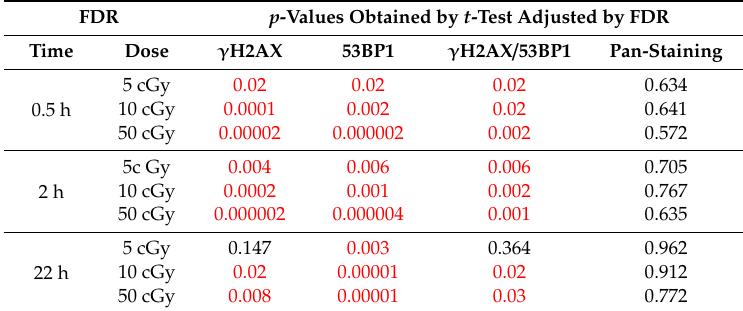
Table 2. Comparison of DNA repair foci and pan-staining in irradiated and control cells. Effect of irradiation was statistically compared with the sham-irradiated sample at the same time-points after radiation using a t -test adjusted for multiple comparisons by FDR. Statistically significant values are marked in red. Table 3. Slope of linear response (either up to dose of 10 cGy or up to 50 cGy) for γH2AX, 53BP1, and FDR p -Values Obtained by t -Test Adjusted by FDR co-localized γH2AX/53BP1 as measured at different post irradiation times.